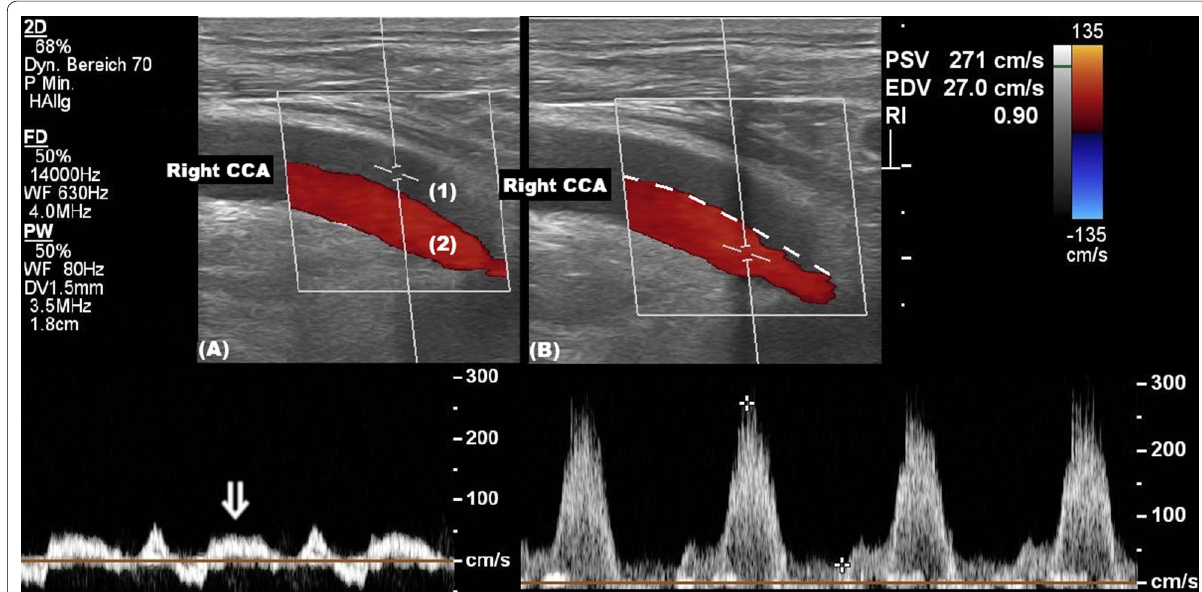
Fig. 2 Duplex sonography of the right common carotid artery. Note the dissection membrane (dashed line) separating two distinct lumina, each with different flow profiles. The false lumen (1) exhibits systolic and diastolic orthograde flow (arrow). The true lumen (2) also displays orthograde flow, but is narrowed to a luminal stenosis of 50% (peak systolic velocity 271 cm/s, reference range 29–178 cm/s